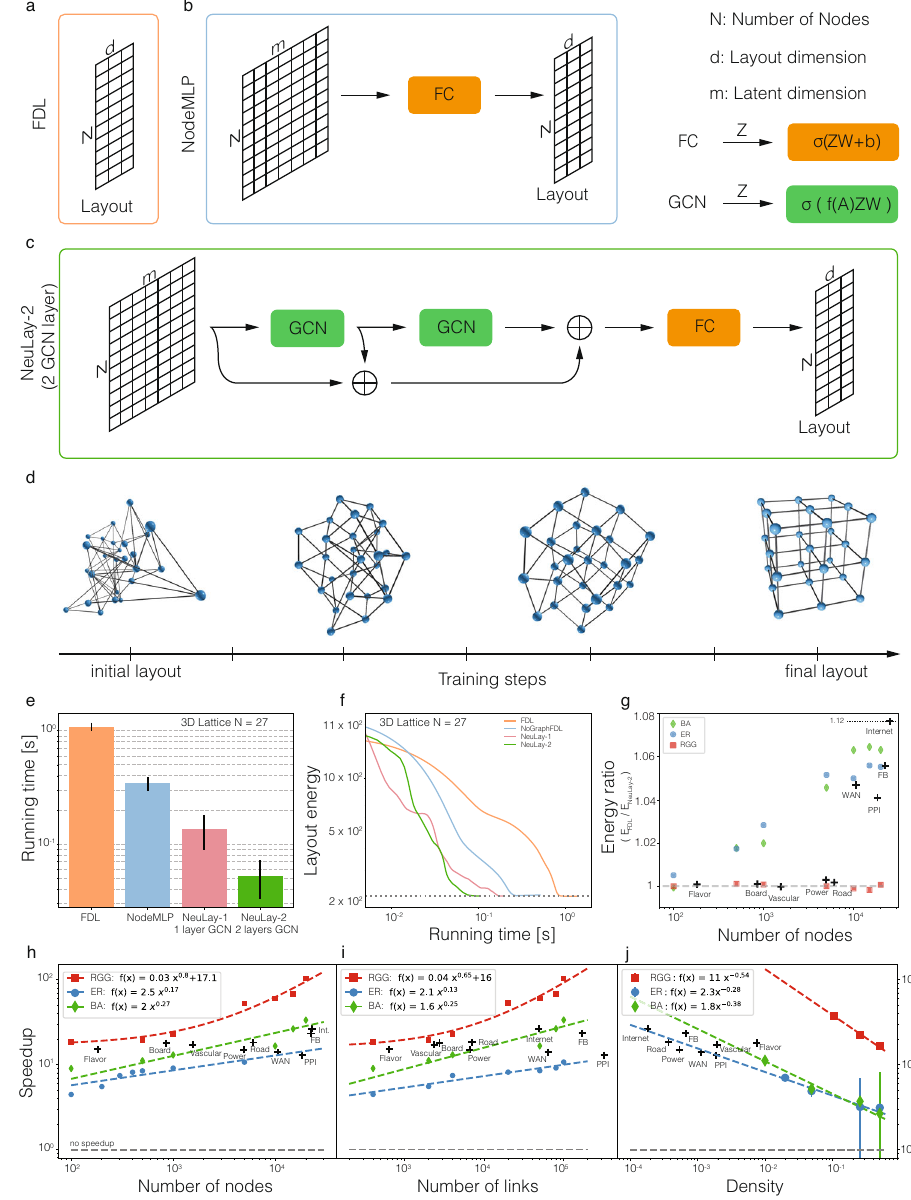
Fig. 1 | Laying out networks using neural network. a FDL optimizes the d dimensional node positions to fi nd a network layout. b NodeMLP replaces the d dimensionalinputby aneuralnetworkthatreliesonafullyconnectedlayer ( FC )to project the high dimensional embedding to the d dimensional layout. c NeuLay encodes the graph structure by graph neural networks, ( GCN ), that maps the adjacency matrix to the node positions. We fi nd that for large networks, two GCN layersareoptimal,asmorethantwolayerscanslowdownthecomputation,whilea single layer does not offer the highest speedup. d The evolution of a simple cubic lattice, starting from a random con fi guration, showing its gradual convergence to thelowestenergystateastheFDLalgorithmidenti fi esitslayout. e Therunningtime of the four tested models for a cubic lattice with 27 nodes. f The NeuLay-2 (green) achievesthesame fi nalenergystateasallothermodelsbutconvergesfaster. g The energy ratioof NeuLay-2 and FDLfornetworks generatedbydifferent models(BA,